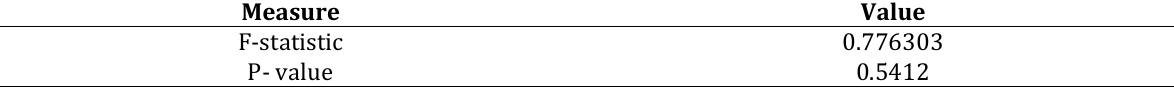
Table 25: Heteroskedasticity Test: Breusch-Pagan-Godfrey Measure Value